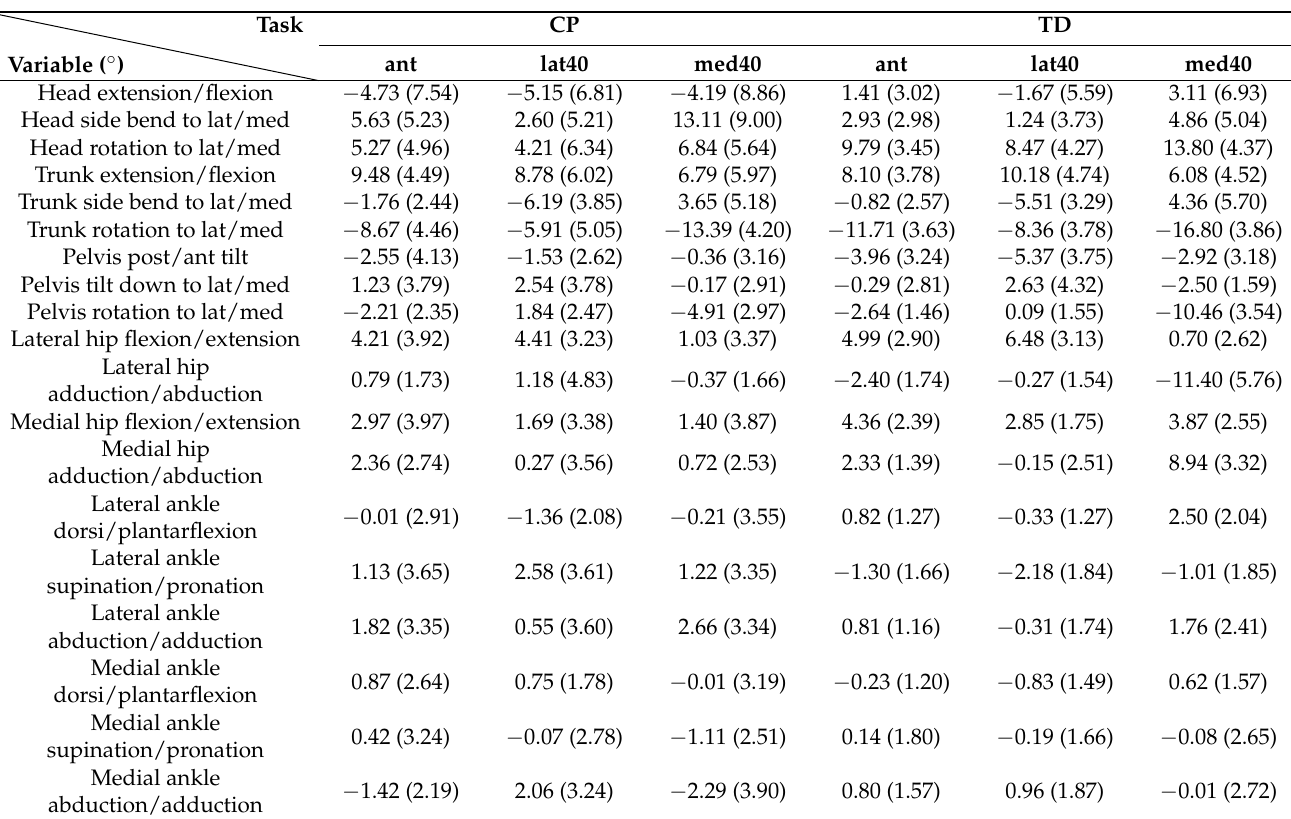
Table 3. Mean and standard deviation of dependent variables of angular changes in axial and lower extremity components during the hand deceleration